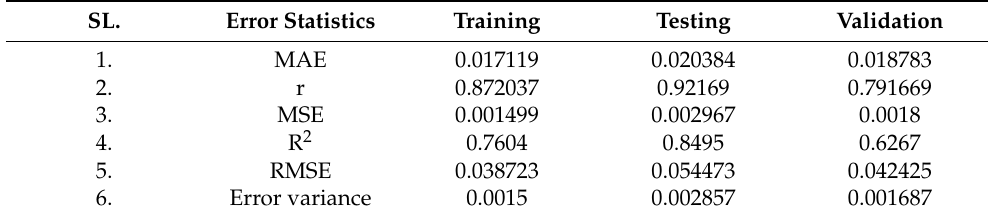
Table 6. Error statistics of MLR model at Polavaram, Godavari River Basin. SL.